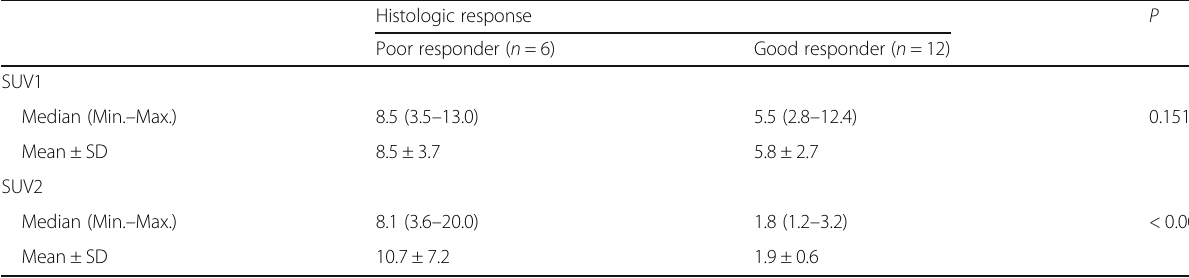
Table 2 Relation between histologic response according to SUV